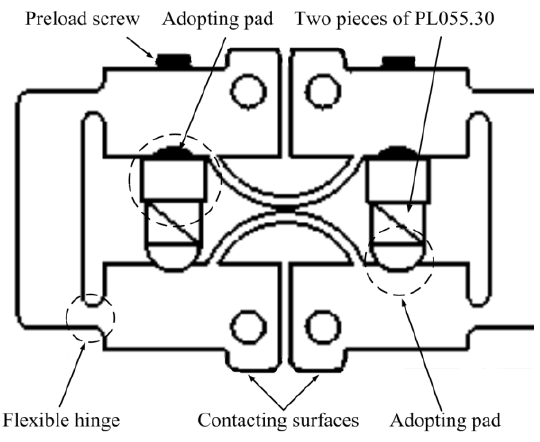
Figure 7. Details of clamping elements.